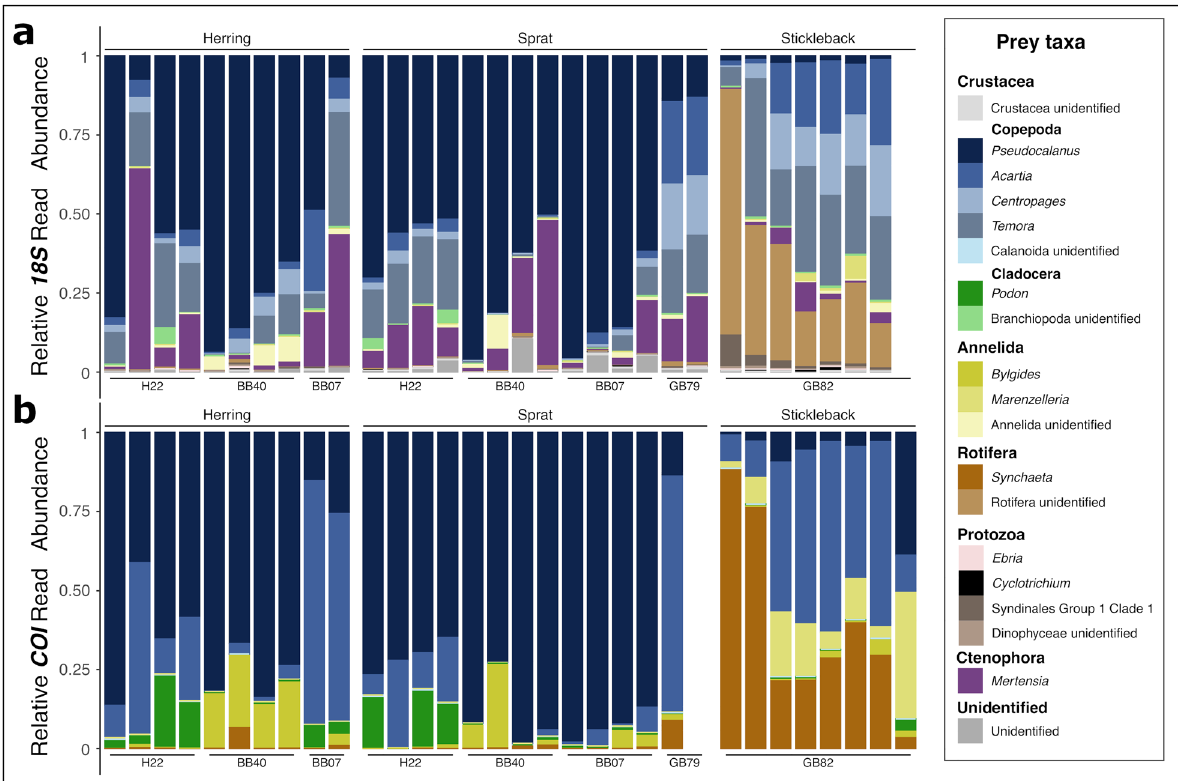
Figure 1. Prey composition of the planktivorous fish species herring ( Clupea harrengus ), sprat ( Sprattus sprattus ) and stickleback ( Gasterosteus aculeatus ) in the southern Baltic Sea shown as relative abundance of ( a ) 18S rRNA and ( b ) COI sequence read per prey taxa. The bars represent unique biological abundance of Temora reads were twice as high in stickleback (27%) compared to herring (13%, P = 0.038) and sprat (10%, P = 0.0064, Supplementary Table S1). The ctenophore Mertensia was detected in higher proportions in the sequence reads of herring (15%) and sprat (13%) compared to stickleback (3%), but the beta regres- sion revealed no significant differences between the fish species ( P > 0.05, Supplementary Table S1). The 18S showed that rotifers constituted about a third of stickleback’s gut content sequence reads (34%), while being almost absent in the gut content of herring (0.2%) and sprat (0.4%) ( P < 0.001, Supplementary Table S1). More specifically, the COI revealed that the rotifer S. baltica was more associated with stickleback (39%) than with sprat and herring (ca. 1%, P < 0.001, Supplementary Table S1). Based on the Bray–Curtis distance of both gene markers reads, the diet of the two clupeids sprat and herring overlapped at more than 60% (Fig. 2c), which was confirmed by pairwise permANOVAs (Supplementary Table S2). Stickleback occupied a different niche than sprat (BCI 18S = 19.9%, BCI COI = 18.08%, P < 0.001) and herring (BCI 18S = 22.74%, BCI COI = 25.66%, P < 0.001). Moreover, ANOVA based on the Shannon Index revealed that stickleback fed on a higher diversity of prey than the two clupeids (F 2,58 = 10.016, P < 0.001, Supplementary Fig. S2). Few rotifer reads were associated to sprat larvae (0.04% and 8.7% for 18S and COI , respectively). However, both barcodes showed a strong contribution of copepods and cnidarians to sprat larvae diet, while 18S identified about three times more taxa than COI (Supplementary Fig. S2). Results from qPCR verified high abundances of rotifers in the gut content of stickleback (on average, a sig- nal equivalent to > 2.29 × 10 6 rotifers 18S gene copies per stickleback gut) (Fig. 3). This concentration was more than 40 times as high in stickleback as in herring or sprat (ANOVA of the log-transformed concentrations, F 2,26 = 8.45, P = 0.0015). The qPCR found no detectable concentration of rotifer 18S associated to the copepods Acartia , Temora , Centropages , Eurytemora , and Pseudocalanus , nor to the cladocerans Evadne and Bosmina (data not shown). The microscopic analysis of gut content revealed that copepods were more abundant in sprat (on average 192 copepods per gut, representing 54% of their prey) and herring (565 copepods, 62%) compared to stickleback (105 copepods, 3%) (Fig. 4a). We also found cladocerans to be abundant in some of the clupeid’s guts (on average 120 cladocerans per gut in sprat, 34% of their prey and 347 in herring guts, 38% of their prey) but less abundant in the stickleback guts (13 cladocerans per gut, 0.4%). Stickleback guts were mainly filled with rotifer eggs and contained on average 3400 eggs per gut, while no rotifer eggs were detected in sprat nor herring (Fig. 4b,c).